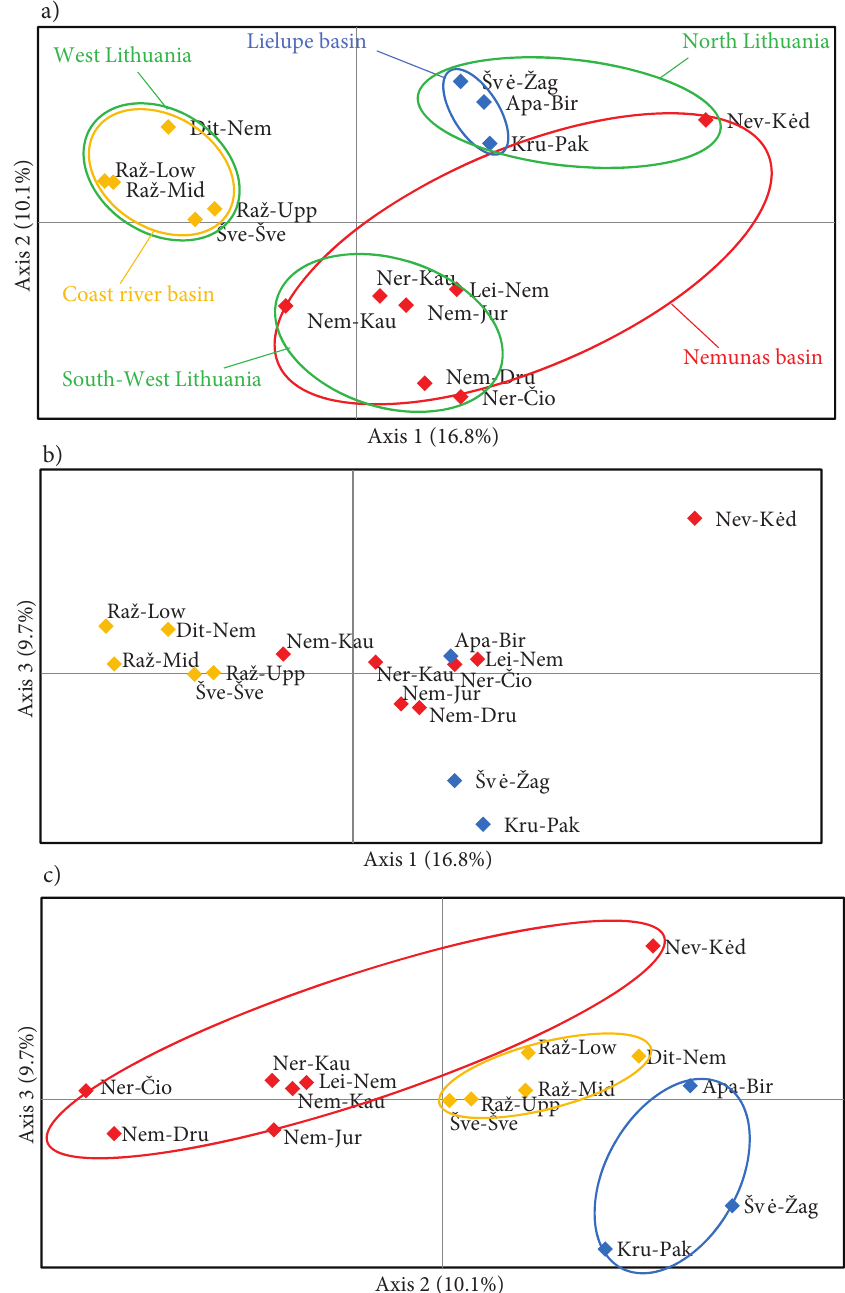
Figure 3. AFLP loci-based clustering patterns of 15 populations of Lithuanian L. salicaria , revealed by principal coordinate analysis (PCoA; principal components 1 vs 2 (a); 1 vs 3 (b); 2 vs 3 (c). Yellow, blue and red colors separate respectively Seaside River basin, Lielupe basin, and Nemunas basin. Green color separate geographic distribution of populations: North